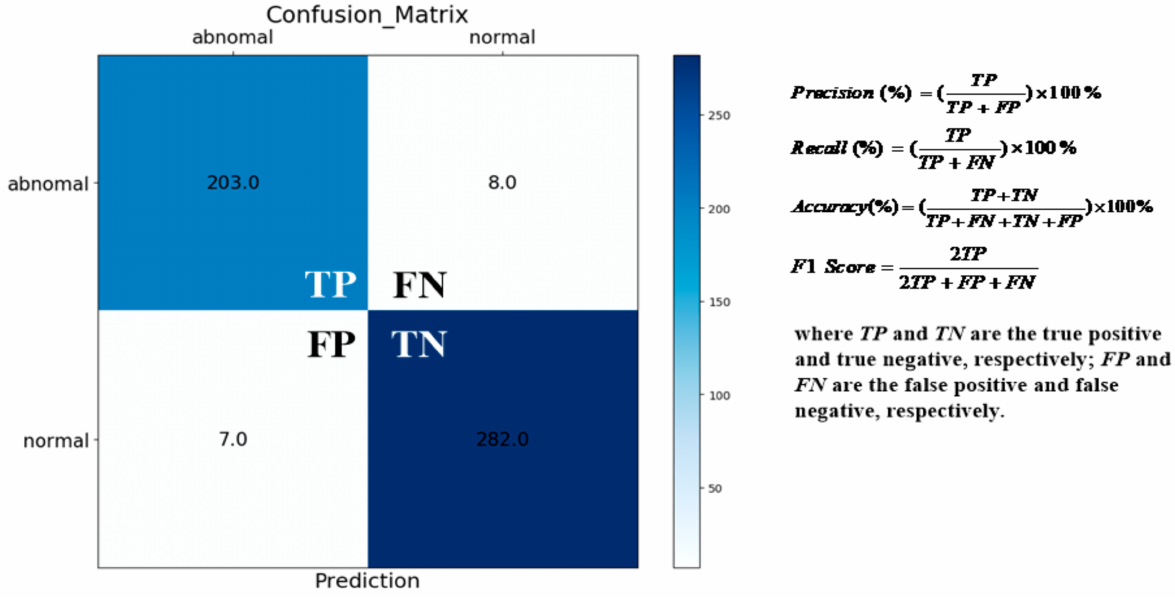
Figure 9. Confusion matrix for classifier’s testing results and formulas for the evaluation